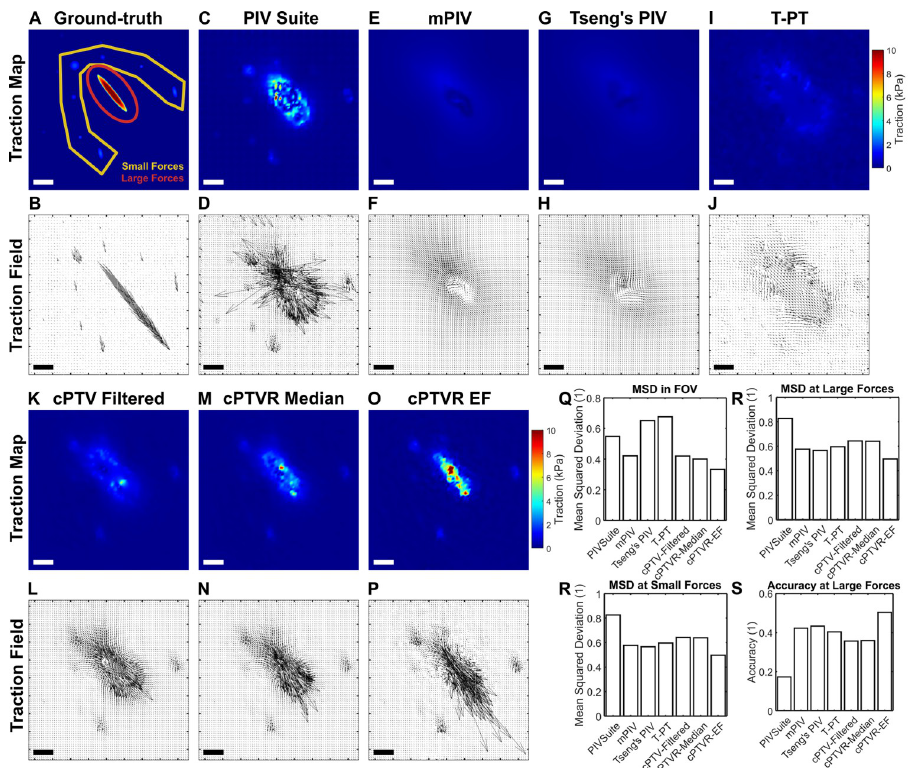
Fig 5. cPTV-retracking method with the enlargement factor leads to the most accurate traction reconstruction for large forces. (A) The ground-truth traction map, the same as in Fig 1A. (B) The ground-truth traction vector field. (C-P) the traction maps (C,E,G,I,K,M,O) and the traction vector fields (D,F,H,J,L,N,P) reconstructed from displacement fields by PIV Suite (C,D), mpiv (E,F), Tseng’s PIV (G,H), T-PT (I,J), cPTV with outlier filtering (K,L), cPTV-Retracking with a median model vector (M,N), and cPTV-Retracking with the enlargement factor (O,P). (Q-S) Bar plots of the mean-squared-diviation (MSD) for the measured force fields by the six tracking methods quantified over the entire field of view (Q), large force area (R), and small force area (S). (T) A bar plot of accuracy for the measured force fields by the six tracking methods over the large force area. vectors (Fig 5O and 5P). Quantifying the mean-squared deviation confirmed that cPTVR with the enlargement factor, or cPTVR-EF was able to produce the traction field with least deviation from the ground truth traction field (Fig 5Q). The lowest MSD exhibited by cPTVR-EF was attributed to the reduced deviation over the large force region (Fig 5R) as well as over the region of small forces (Fig 5S). Quantification of the vector accuracy also confirmed that cPTVR-EF-based traction produced the most accurate field compared to other methods (Fig 5T). Together, the traction reconstruction and comparison suggest that cPTVR-EF enables better detection of the large forces by being able to detect the large, local displacement vectors. To test whether cPTVR-EF, which we refer to just cPTVR from now on, can track an exper- imental bead images for TFM, we conducted a TFM experiment with human bone osteosar- coma epithelial (U2OS) cells on a 4 kPa silicone gel coated with 40 nm-diameter fluorescent beads. We collected the bead images under total internal reflection fluorescence microscope when cells were adhered to the gel surface and after they are released (Fig 6A). The pair of the bead images were processed with PIVSuite, cPTV and cPTVR for displacement measurement (Fig 6B–6D). We picked PIVSuite as a representative PIV method based on the average perfor- mance shown compared to other PIV methods (Fig 1O–1Q). The displacement tracked by PIV Suite showed mostly smooth field except for the failure at one corner (Fig 6B). The